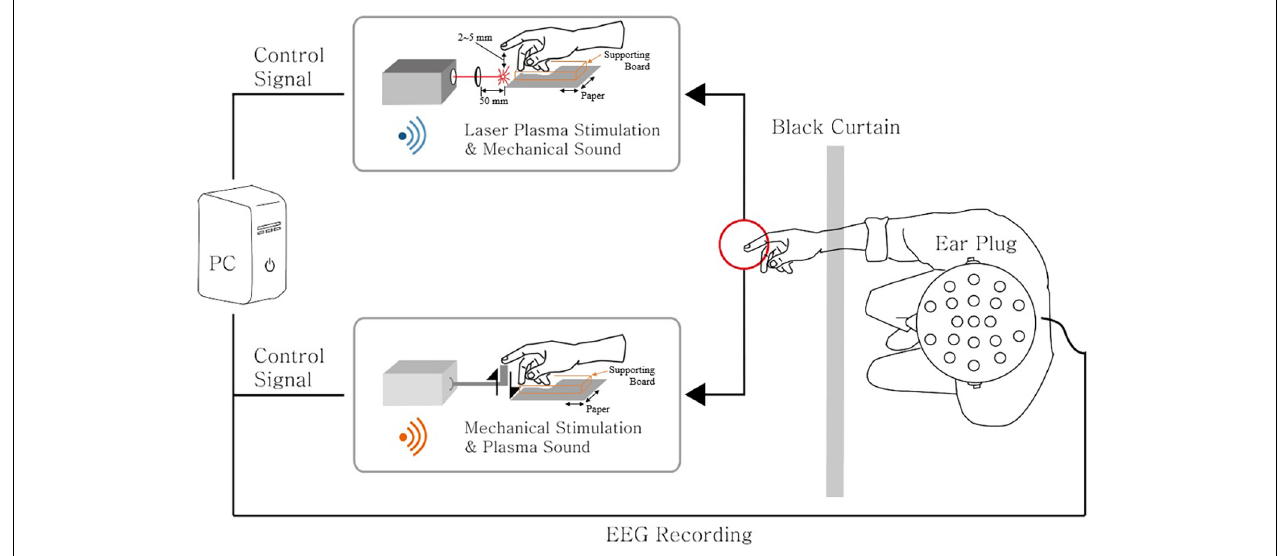
FIGURE 1 | An illustration of the experimental setup. Laser plasma stimulation along with the auditory mechanical sound was provided to the subject’s right index finger. Also, mechanical stimulation along with the auditory plasma sound was provided to the same finger location. The 21-channel electroencephalography (EEG) signals were recorded simultaneously. The subject’s view was blocked by the black curtain to inhibit the visual effects of the stimuli. An ear plug was used to reduce the sound effects induced by stimulations. The laser device and the mechanical actuator were triggered by the control signal generated from the